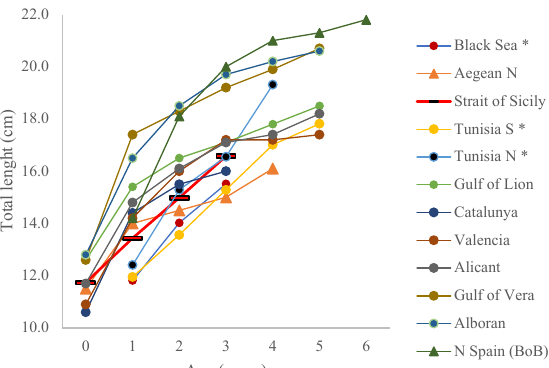
The mean lengths at age over the whole study period were 11.7 cm for Age 0; 13.4 cm for Age 1; 15 cm for Age 2; and 16.6 cm for Age 3. These values of length at age plo tt ed together with similar estimates from several studies showed wide agreement with the literature (Figure 6).